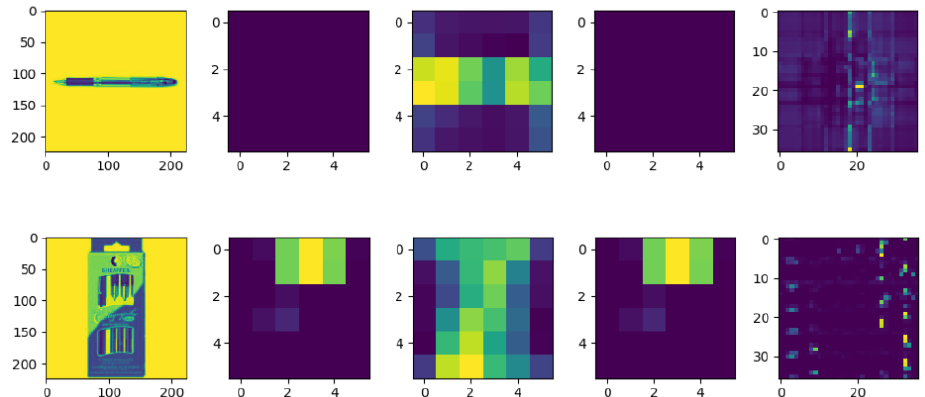
Figure 3. Comparison of feature maps with vs. without attention in Amazon. The 1st column is the original image (sum of 3 channels); the 2nd column is with attention (0 channels); the 3rd column is with attention (sum of 256 channels); the 4th column is without attention (sum of 256 channels); the 5th column is an attention matrix. We can see the amount of information of the 4th column is very small, just as the single channel (i.e., 0 channels) with attention in the 2nd